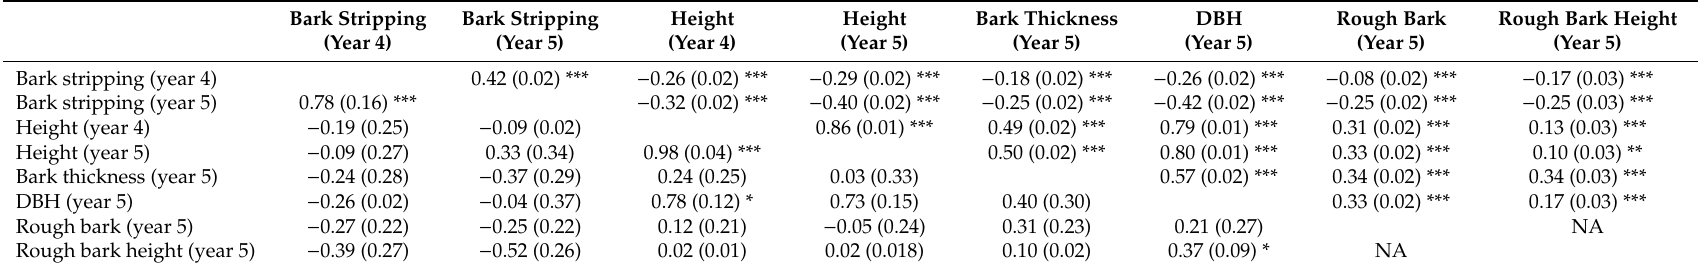
Table 6. Phenotypic (above diagonal) and additive genetic Type A (below diagonal) correlations of traits assessed at the Beulah trial with the standard errors given in parentheses. The significance of the di ff erence of the correlations from zero are indicated: *** = p < 0.001, ** = p < 0.01, * = p < 0.05. NA = not applicable, as only assessed on a specific cohort of individuals.